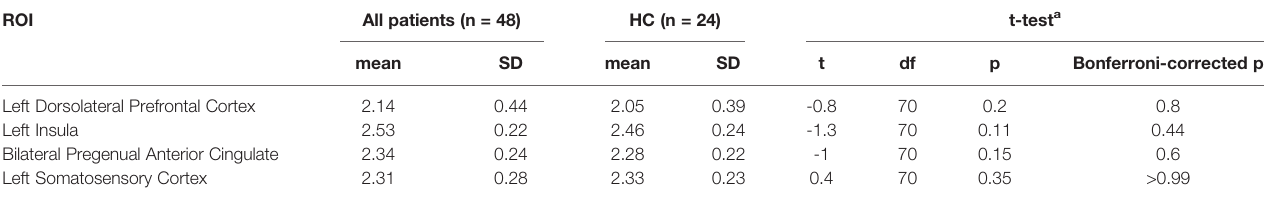
TABLE 3 | Group difference of GABA/water between healthy controls and combined patient group tested with t-test (n = 72). ROI All patients (n = 48) HC (n = 24) t-test a mean SD mean p Left Dorsolateral Prefrontal Cortex